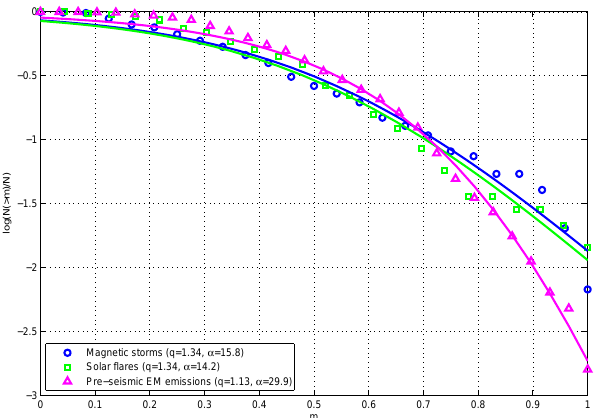
Fig. 5. Searching for the existence of a master universal curve by appropriately scaling the three different cumulative distribution functions of Fig.